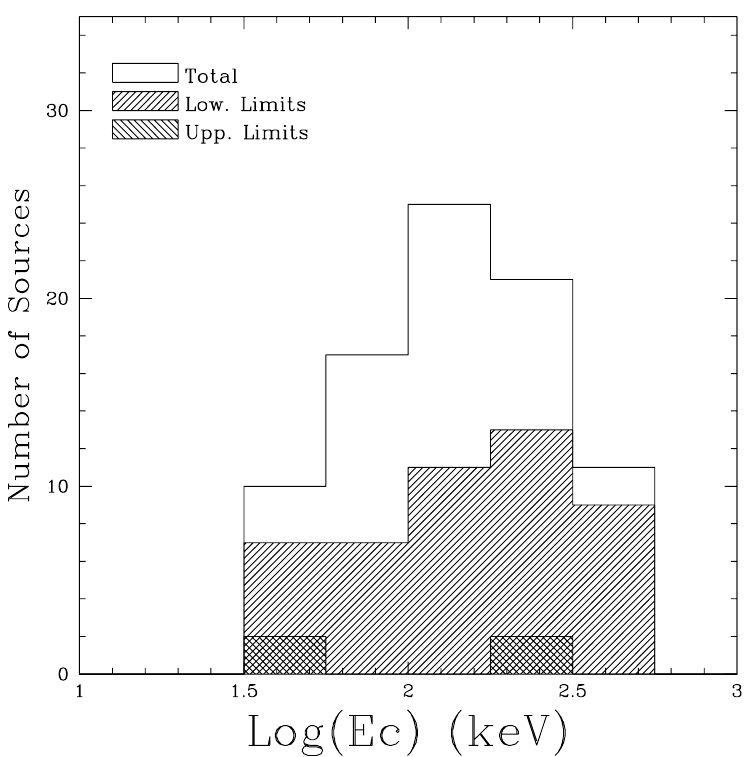
Figure 2. Distribution of E c of local Seyferts determined from the BeppoSAX observations. Taken from Dadina [57].